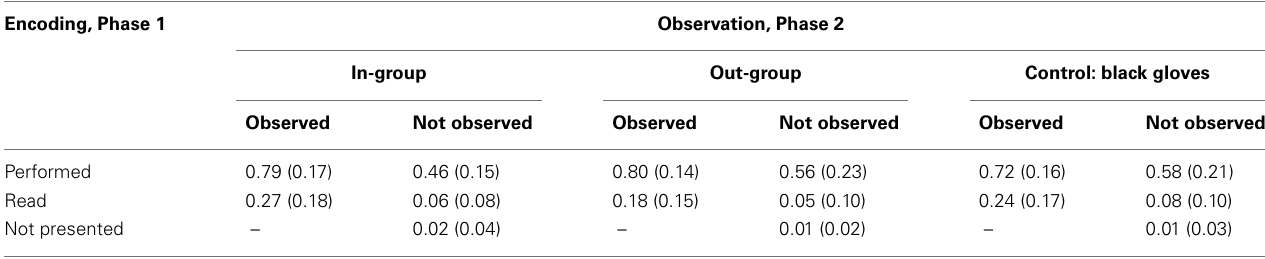
Table 1 | Mean proportion of performed-responses as a function of encoding in Phase 1, observation in Phase 2, and observation group.